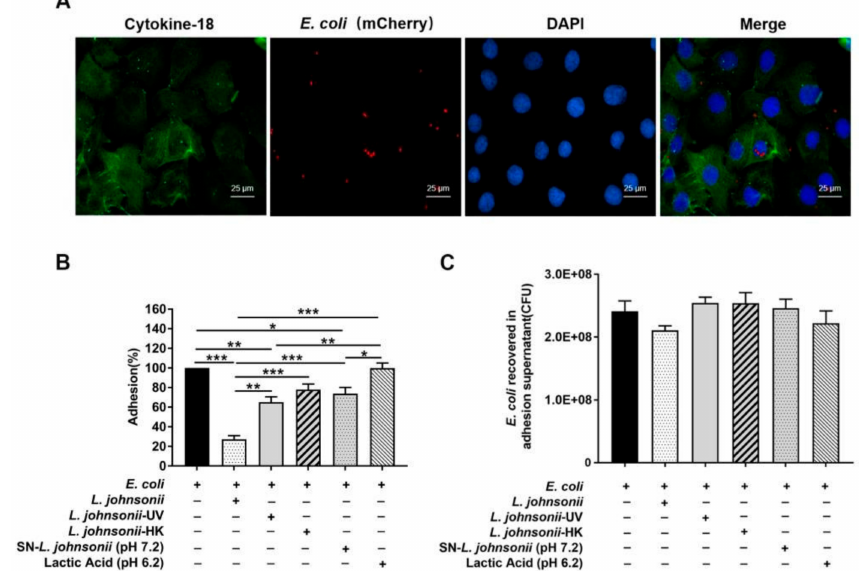
Figure 1. Pretreatment with L. johnsonii L531 decreased the adhesion of E. coli to PMECs. ( A ) Immunofluorescence analysis of the E. coli adhesion (using mCherry- E. coli ) to the primary cultured PMECs. Representative confocal immunofluorescence images showing typical morphology of pure PMECs, which were stained with mouse anti-cytokeratin-18 (green) and DAPI (blue). Scale bar, 25 µ m. Data were representative of three separate experiments. ( B ) The adhesion rate of E. coli in di ff erent treatments. PMECs were harvested at 6 h after E. coli infection. The adhesion assay using E. coli alone serves as a reference. The adhesion rate was presented as the ratio of the number of adhered E. coli in di ff erent treatments to the reference number of adhered E. coli . ( C ) The amount of E. coli recovered in the supernatant of adhesion experiments. Upon E. coli challenge, the amount of E. coli recovered was counted in the supernatant of adhesion experiments at 6 h post-infection. Data were exhibited as the mean ± SEM from three separate experiments. * p < 0.05, ** p < 0.01, *** p < 0.001. After 6 h following E. coli stimulation, the number of adherent E. coli was 1.48 × 10 6 ± 1.74 × 10 4 CFU (means ± SEM). Pretreatment with live, UV-irradiated and culture supernatants of L. johnsonii L531 result in the reduction of E. coli adhesion rate to 27.22% ( p < 0.001), 65.16% ( p = 0.003), and 73.86% ( p = 0.025), respectively, whereas no change was observed in cells pretreated with heat-killed L. johnsonii L531 and DMEM / F12 medium acidified with lactic acid (Figure 1B). The internalization of E. coli by PMECs was not observed. Compared with E. coli infection only, there was no alteration for the count of E. coli in the supernatant regardless of treatment (Figure